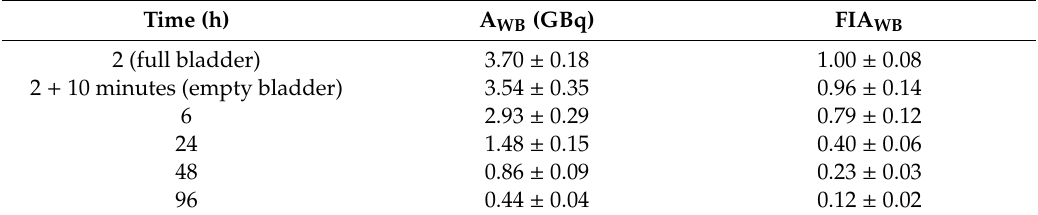
Table 1. Whole-body (WB) activity and associated fraction of injected activity (FIA) values.